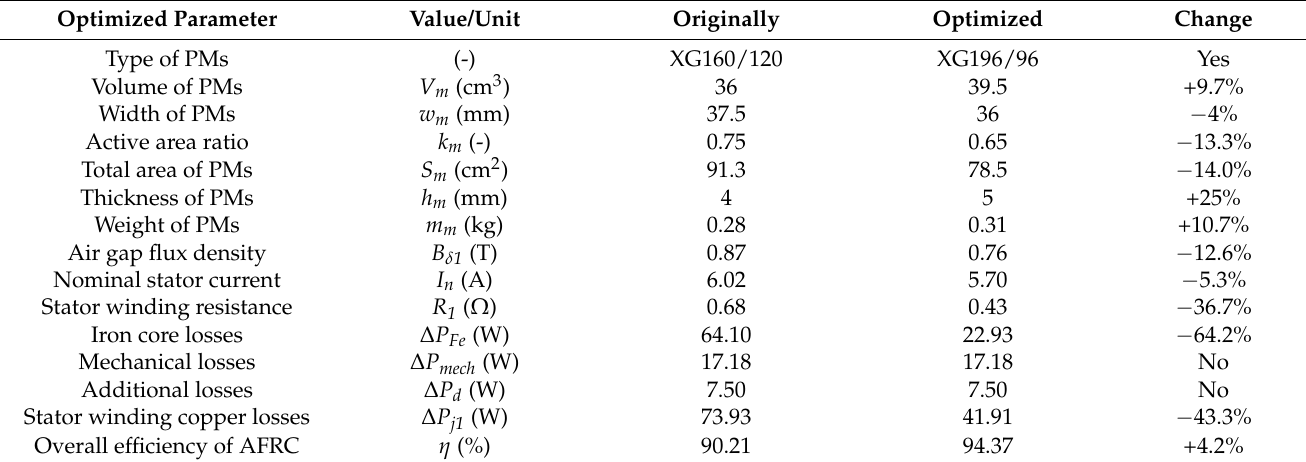
Table 2. Parameters of the AFRC Unit after permanent magnet